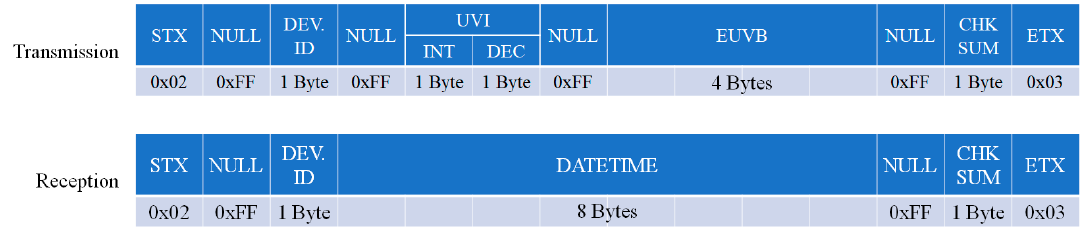
Figure 6. Transmission and reception protocol between the smartphone application and the device.